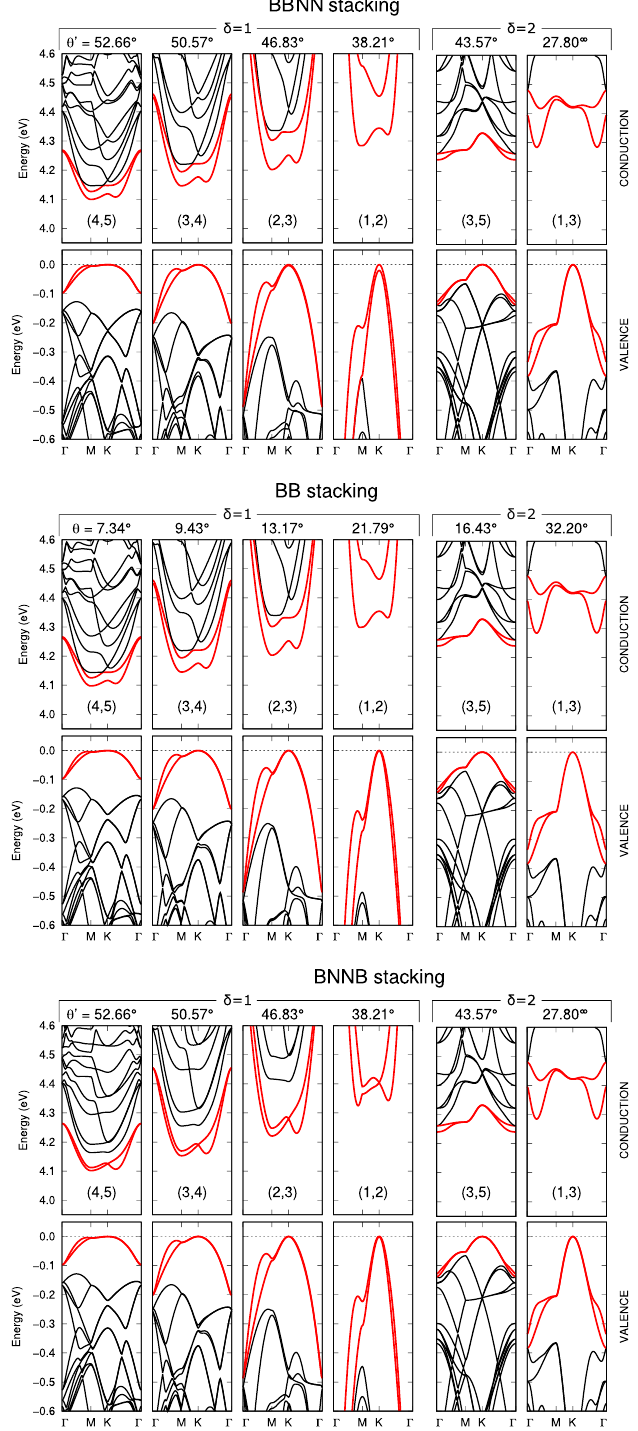
Figure 15: Band structure as a function of the twist angle of the BBNN, BB and BNNB stackings from top to